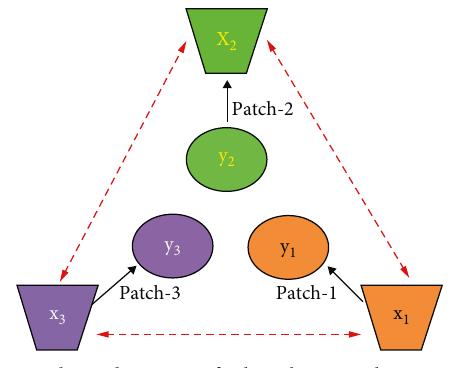
Figure 1: Flow diagram of the three-patch prey-predator